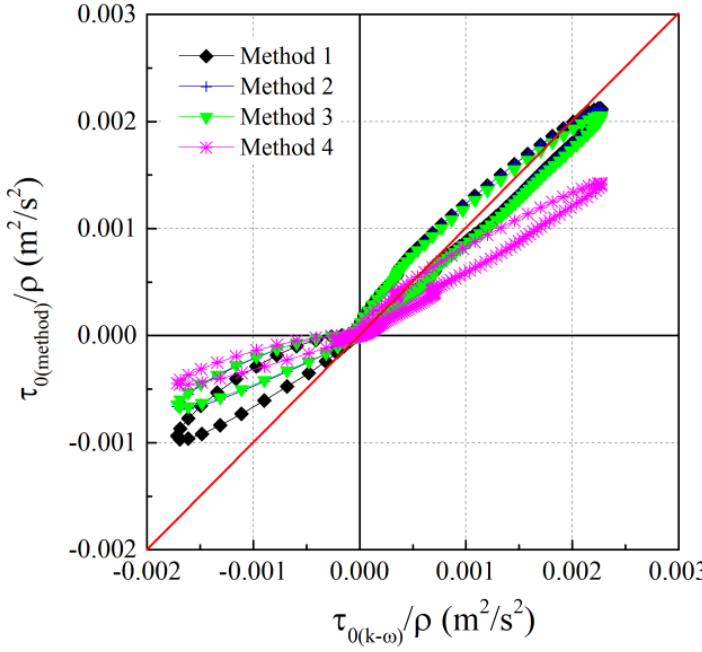
Figure 14. Comparison of other methods with the k- ω model results.